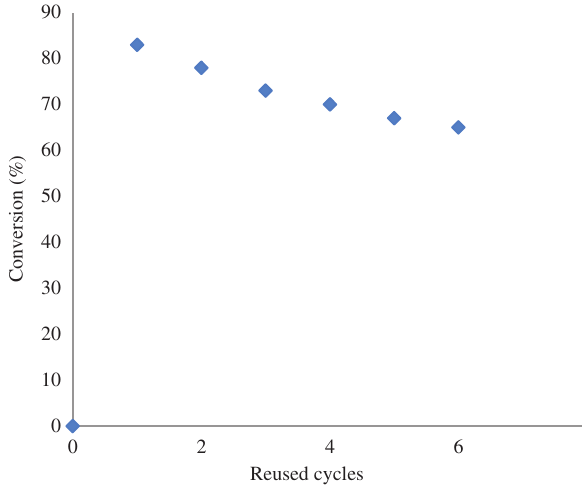
Figure 7: Reusability study performed at hexanol:triacetin ratio 1:1, hexane-3 ml, enzyme loading 4% (w/v), temperature 50 ° C, agitation speed 100 rpm, duty cycle 70% and frequency 25 kHz.